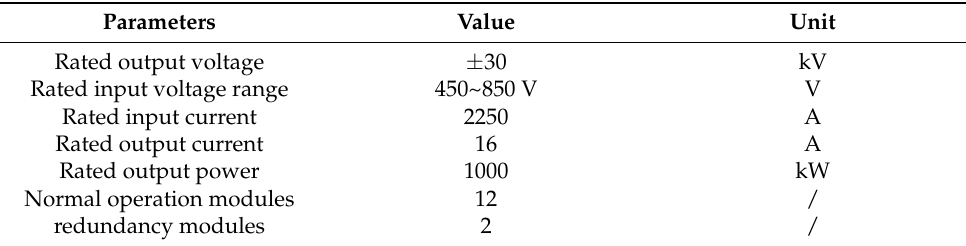
Table 2. Parameters of the DC/DC converter engineering prototype.